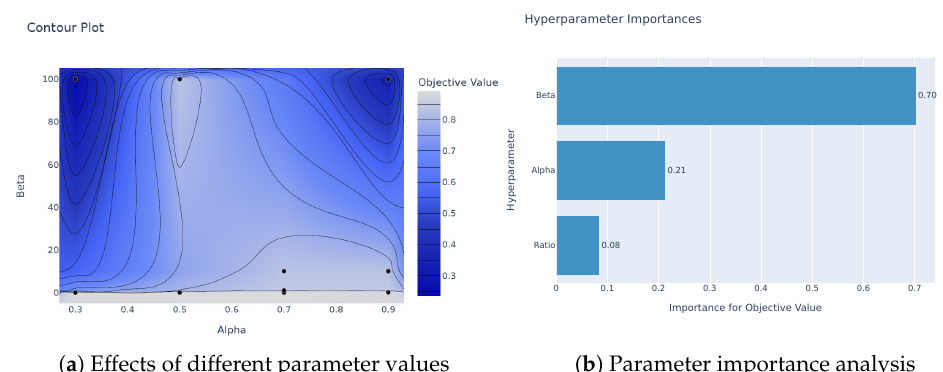
Figure 3. We adopt the Tree-structured Parzen Estimator algorithm to sample the parameters and optimize the value of the AUROC as the objective value, and denote α , β , and r by Alpha, Beta, and Ratio.